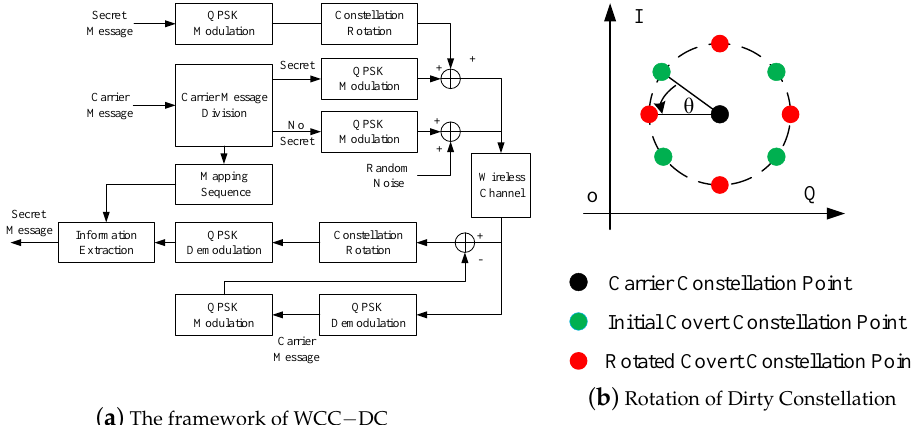
Figure 2. The schematic diagram of wireless covert communication with dirty